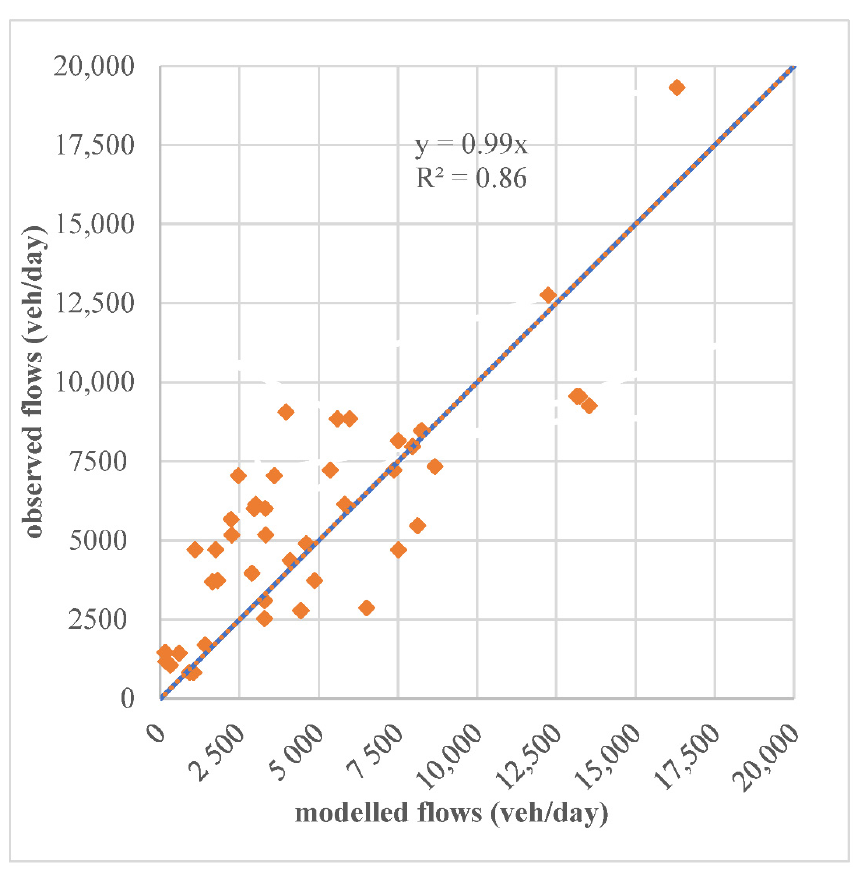
Figure 9. Comparison between revealed and modelled road link flows (after